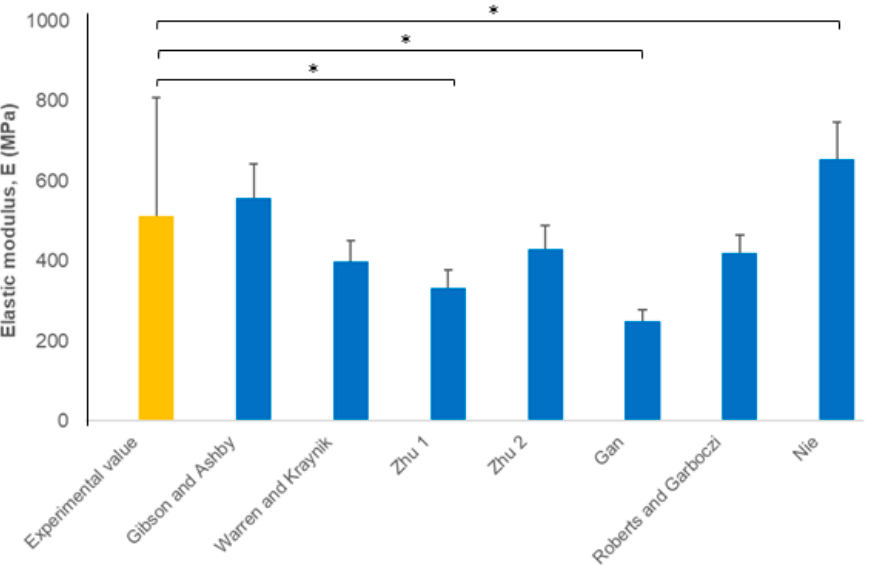
Figure 3. Compressive strength: comparison between the results from Gibson–Ashby model and experimental data ( n = 20, p < 0.05).